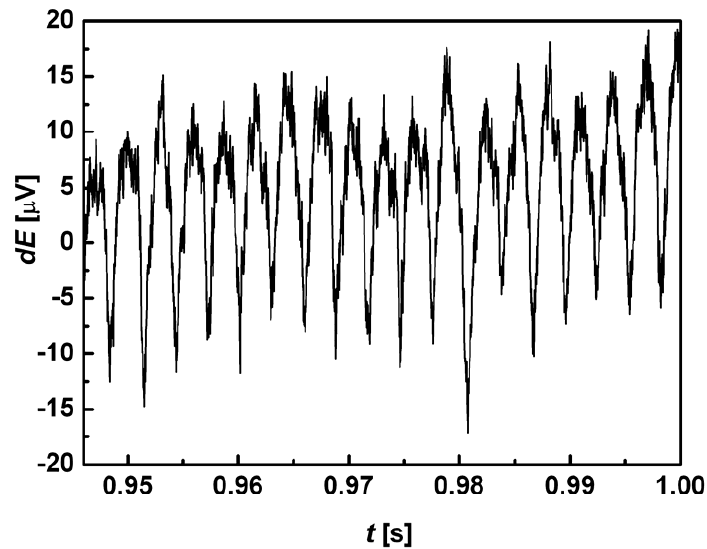
Fig. 5 Relative power spectral density measured on d = 50 μ m Pt microelectrode in a 0.5 M H 2 SO 4 aqueous solution for three different external